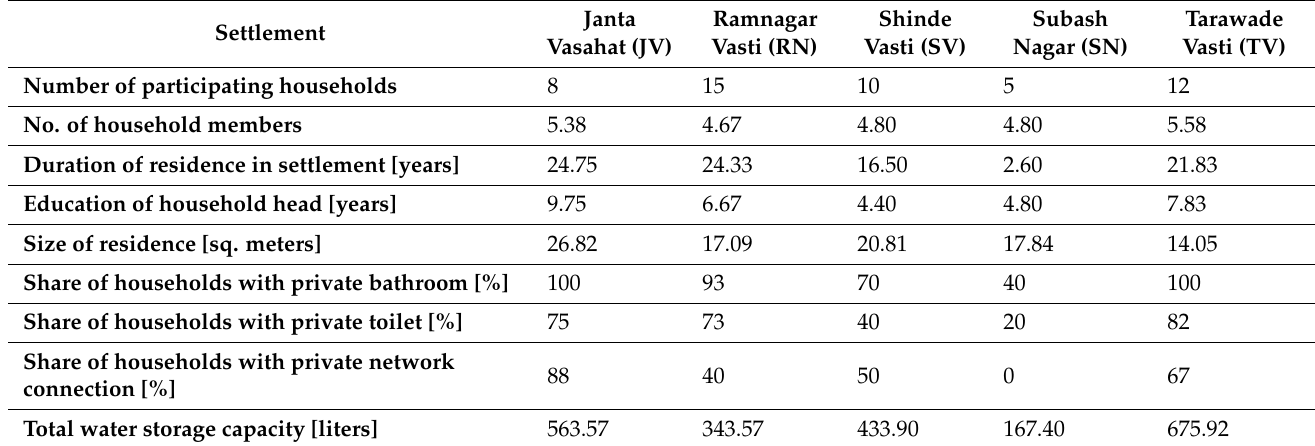
Table 2. Demographic and water-related household data (Data source: